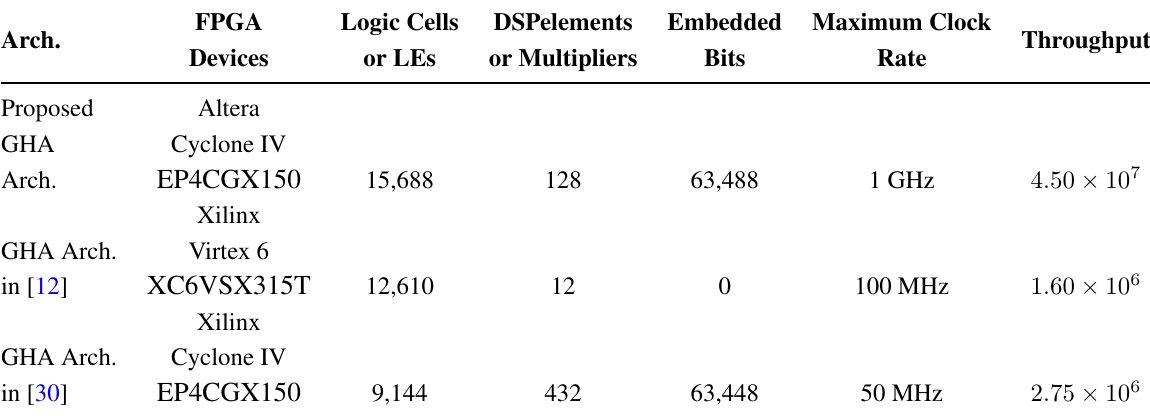
Table 10. Comparisons of the proposed GHA circuit with other FPGA-based feature extraction implementations. LE, logic